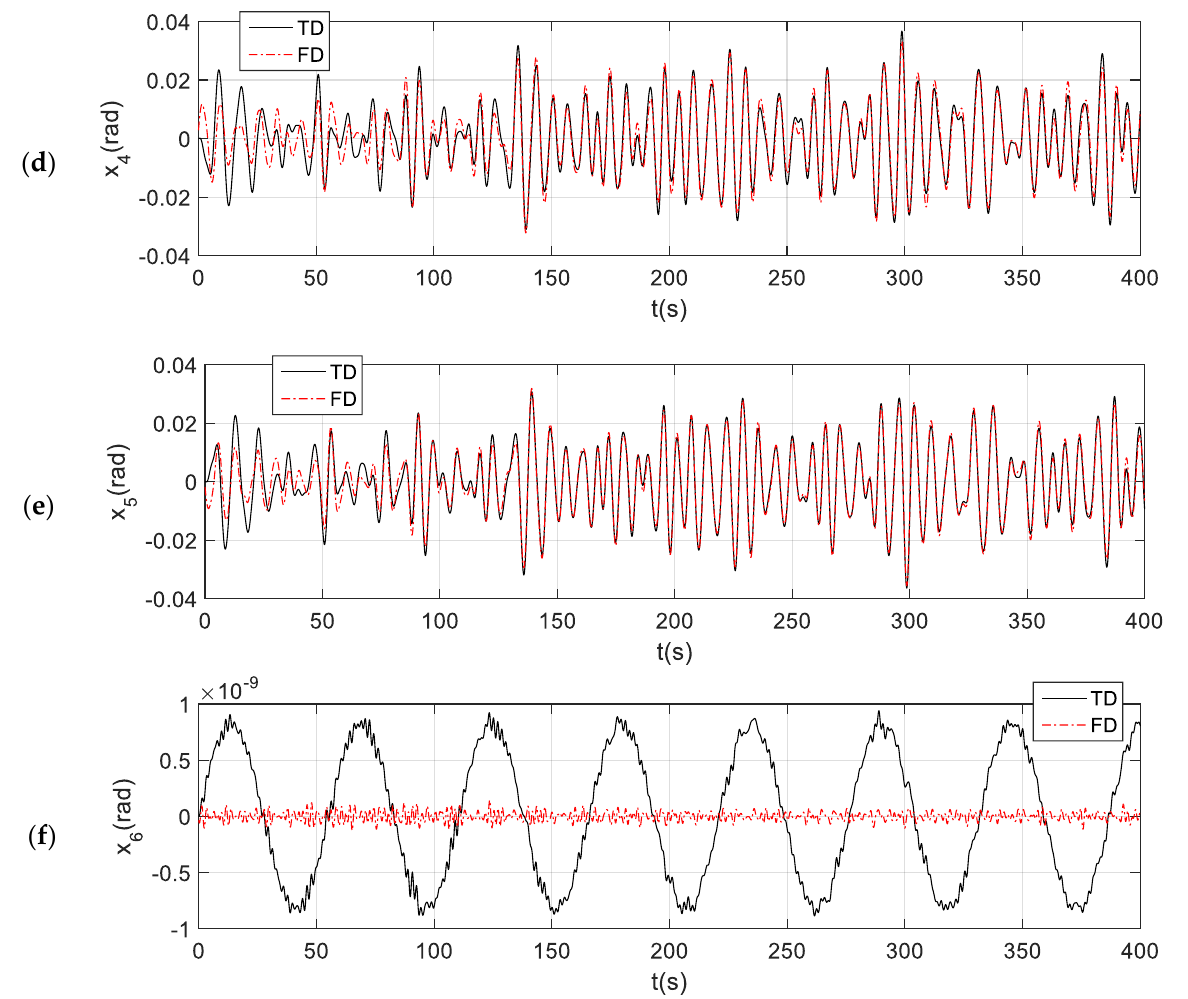
Figure 15. The comparisons of the time histories from the time-domain solution and from the transformation of frequency-domain responses. ( a ) surge; ( b ) sway; ( c ) heave; ( d ) roll; ( e ) pitch; ( f ) yaw.